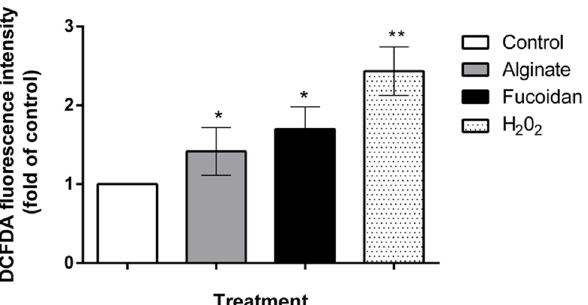
Figure 7. Fucoidan and alginate isolated from C. sinuosa trigger an increase in DCFDA fluorescence intensity, reflecting the enhanced ROS levels in HCT-116 colon cancer cells (mean ± SD; n = 3). Significant differences are indicated as * p < 0.05 and ** p < 0.01 with respect to control.